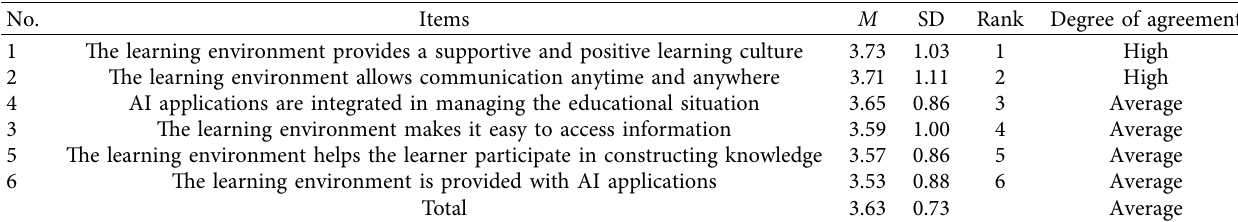
Table 4: Descriptives of the “learning environment” subdimension in descending